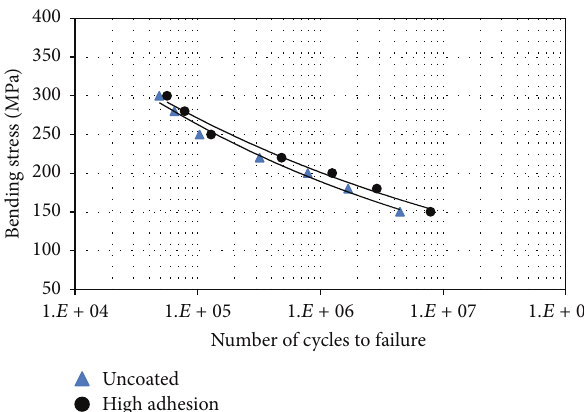
Figure 17: S/N curve of fretting fatigue for uncoated and TiN coated specimens with highest surface adhesion